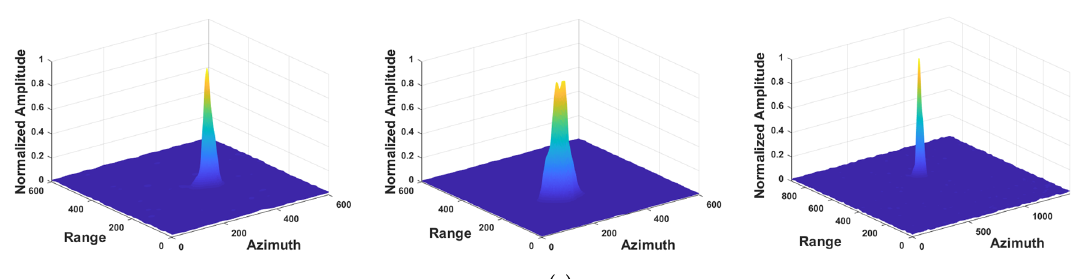
Figure 11. Normalized amplitude of the three detected targets ( a ) VH amplitude; ( b ) VV amplitude; ( c ) reflection symmetry metric. Table 4. SCRs (unit: dB) of the three detected ship targets in different polarimetric parameter images.